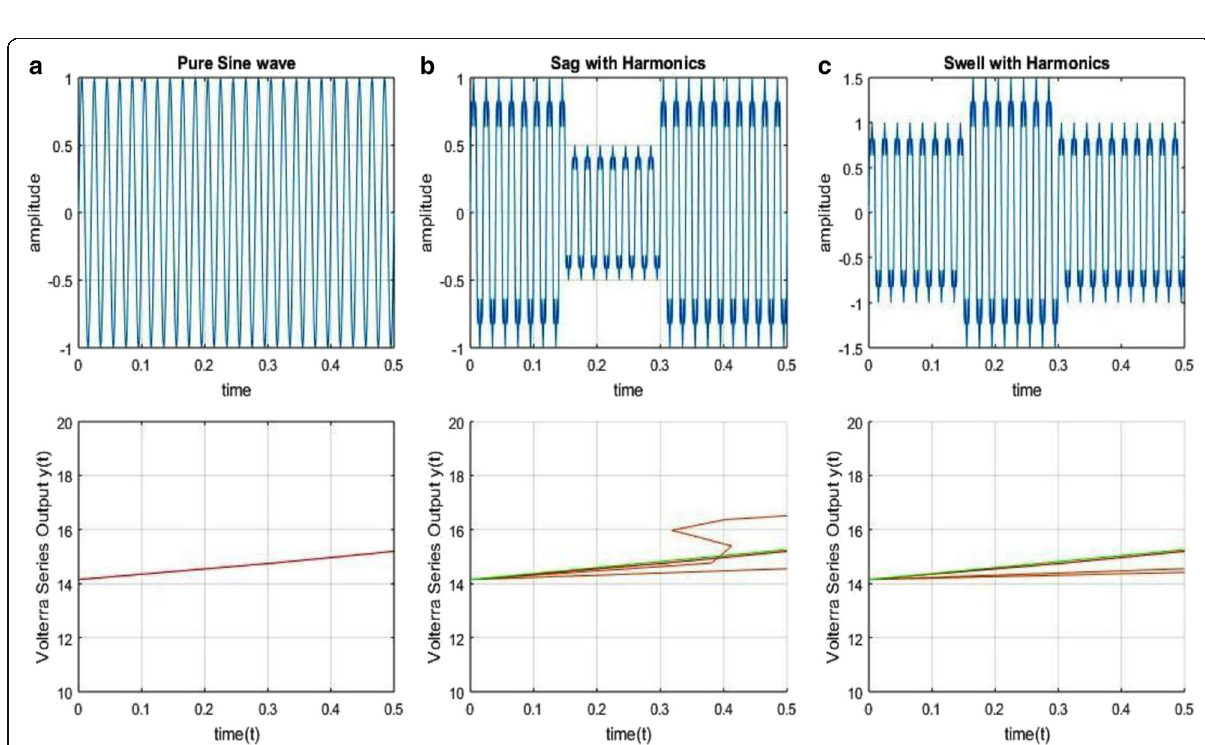
Fig. 3 Volterra series output for a Pure sine wave b sag with Harmonics b Swell with